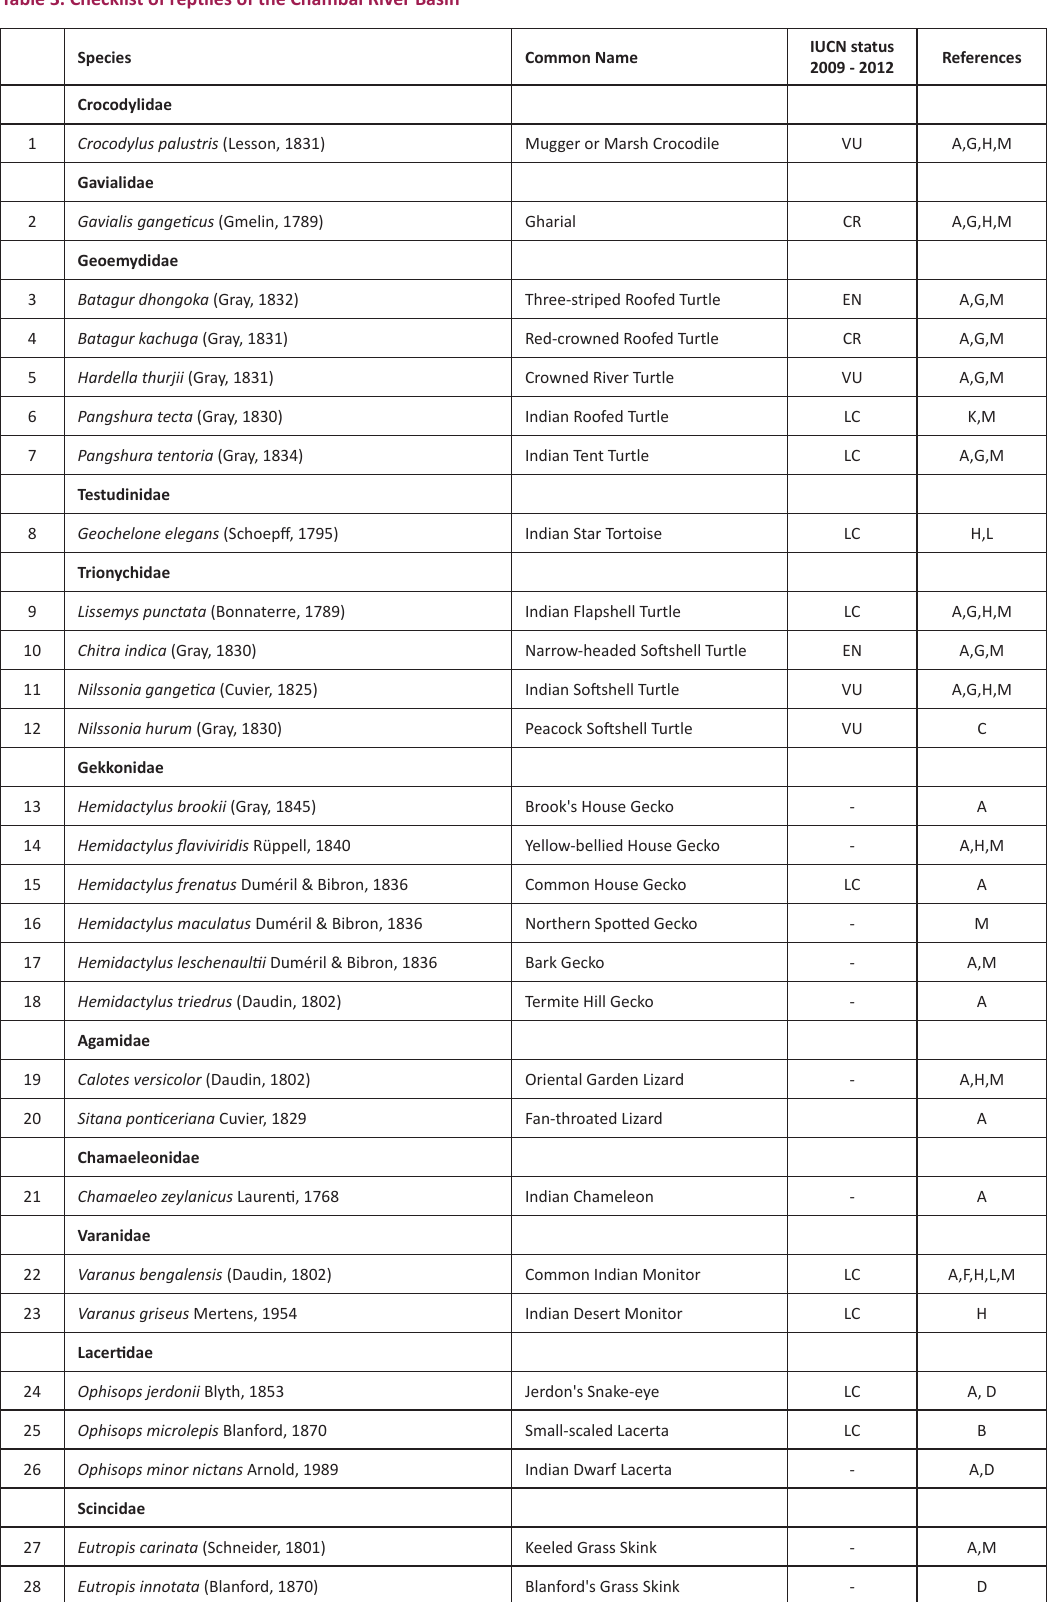
Table 3. Checklist of reptiles of the Chambal River